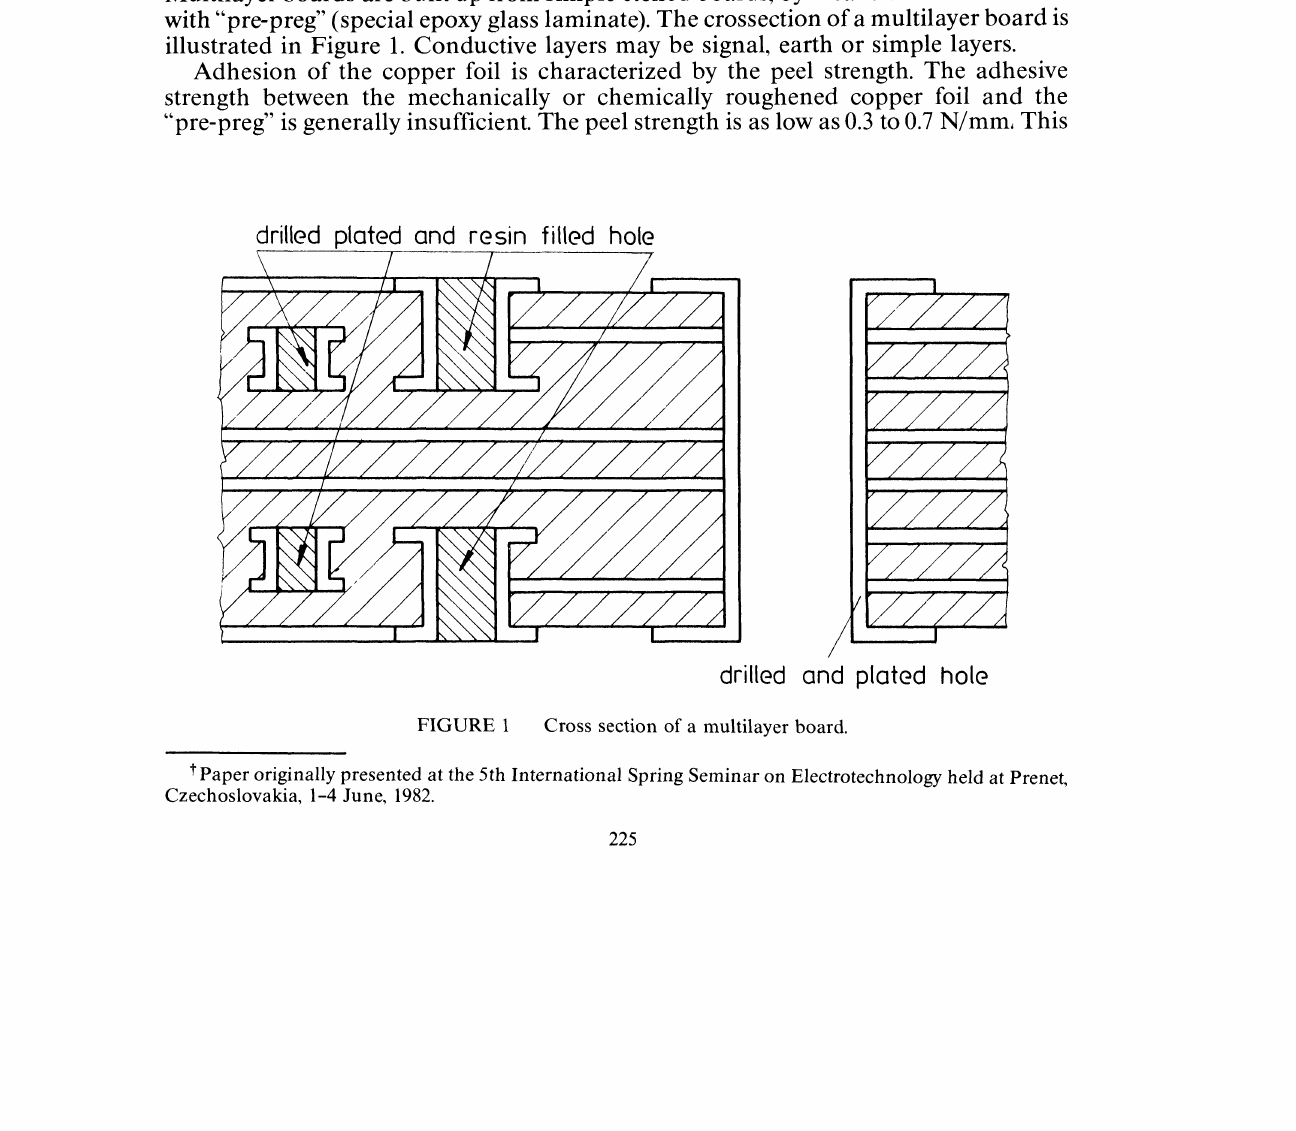
FIGURE Cross section of a multilayer